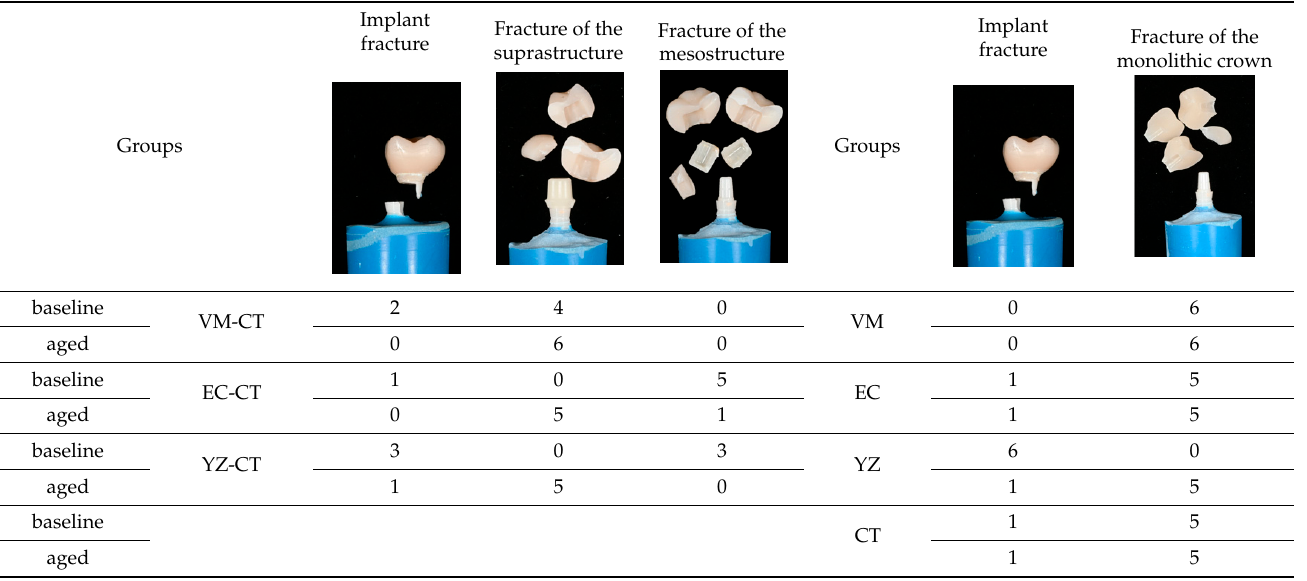
Table 3. Fracture type of the specimens.